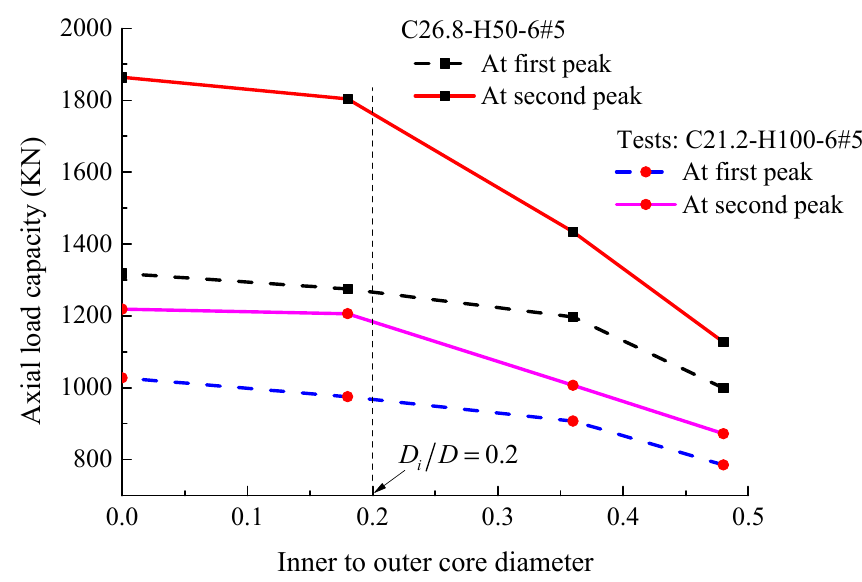
Figure 25. Effect of increasing the D i / D ratio on the axial load capacity.